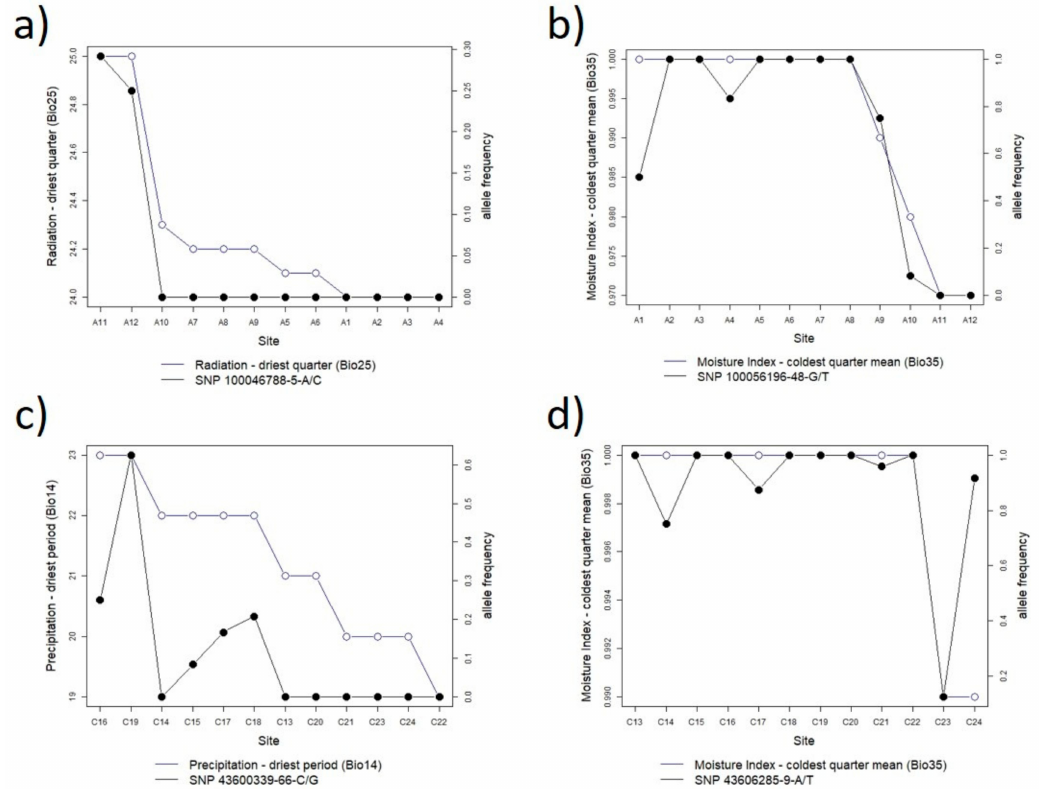
Figure 6. The strongest correlations for Astartea leptophylla with ( a ) radiation of the driest quarter and ( b ) moisture index of the coldest quarter; and the two strongest correlations for Callistachys lanceolata with ( c ) precipitation of the driest period and ( d ) moisture index of the coldest quarter